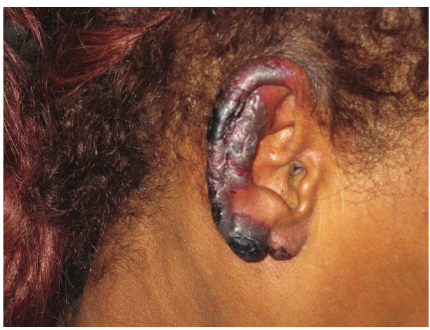
Figure 5: Purpuric retiform patches with erythematous borders and necrotic